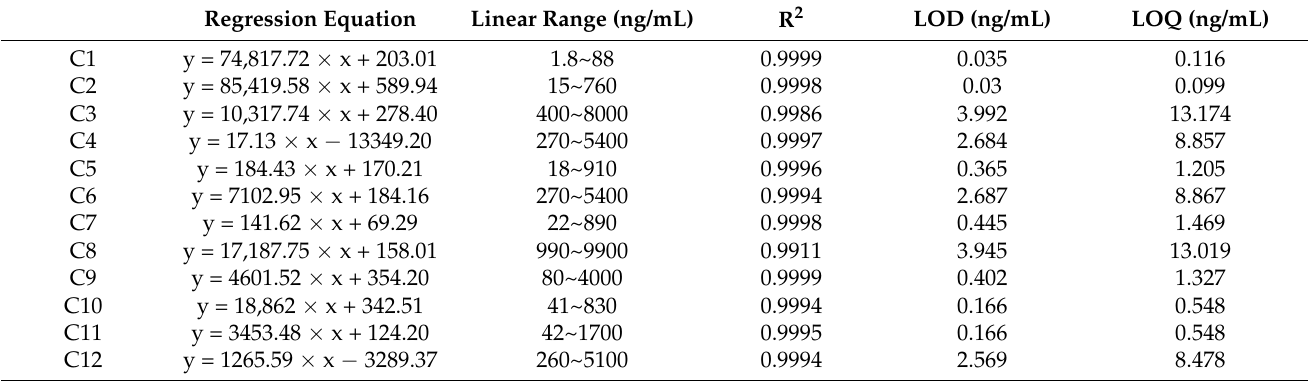
Table 1. Regression equation, LOD, and LOQ of the six dianthrones of 12 compounds.